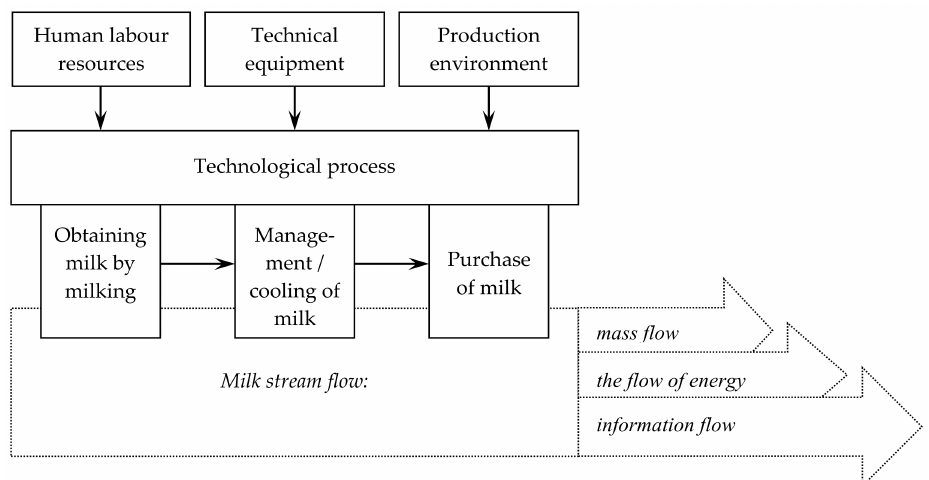
Figure 1. Technological process in dairy production systems, taking into account the group of flow streams and supporting human resources, as well as technical equipment and the production